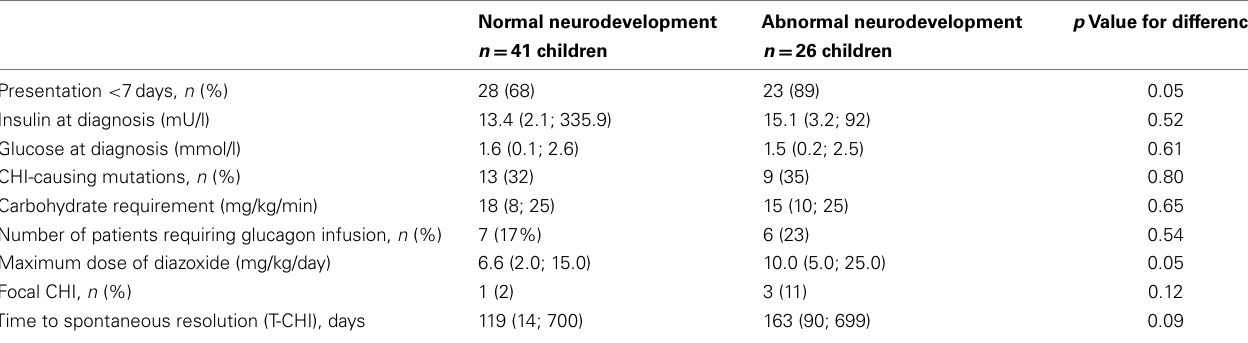
Table 3 | Diagnostic and treatment characteristics in children with normal and abnormal neurodevelopment: categorical variables are represented as numbers of patient and as a percentage (%) of the cohort, while continuous variables are represented as median (range). Normal